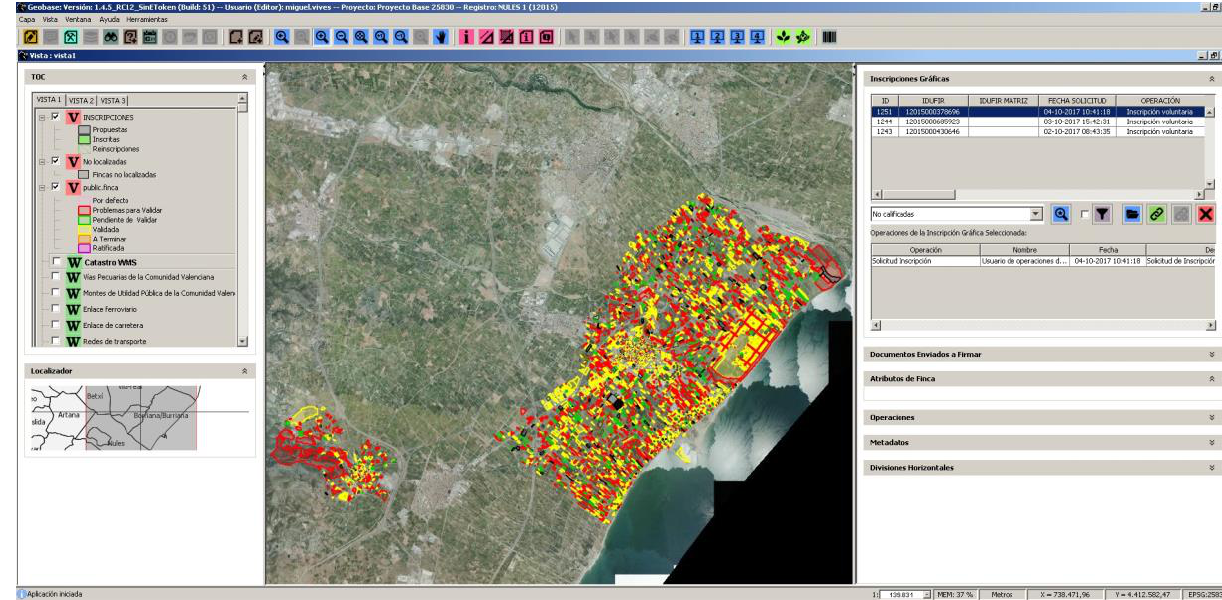
Figure 2. Software Geobase 4. Source: Land Registry Nules 1, Castellon,